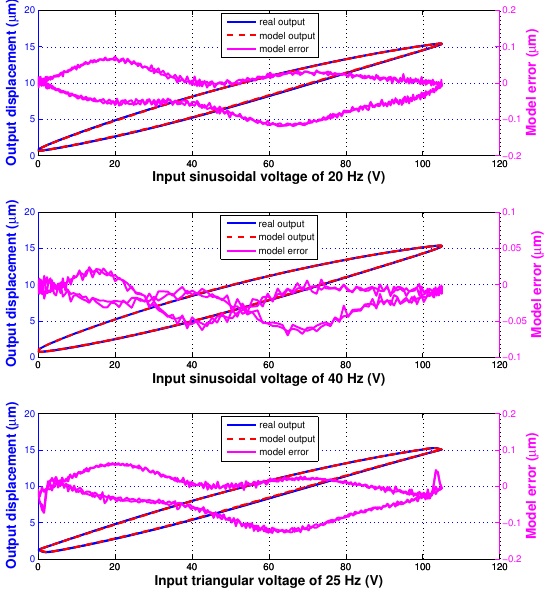
Figure 4. Validation results of the identified hysteresis model under different input signals: ( top ) 20 Hz sinusoidal, ( center ) 40 Hz sinusoidal, and ( bottom ) 25 Hz triangular.